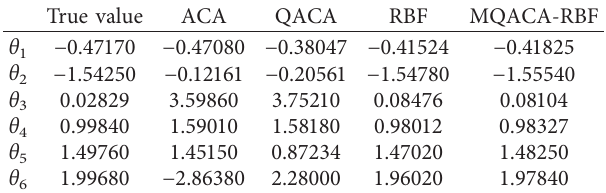
Table 3: Comparison of inverse solutions of ZrARM robotic arm point A and point B ( ° ):B-point inverse solution result comparison.